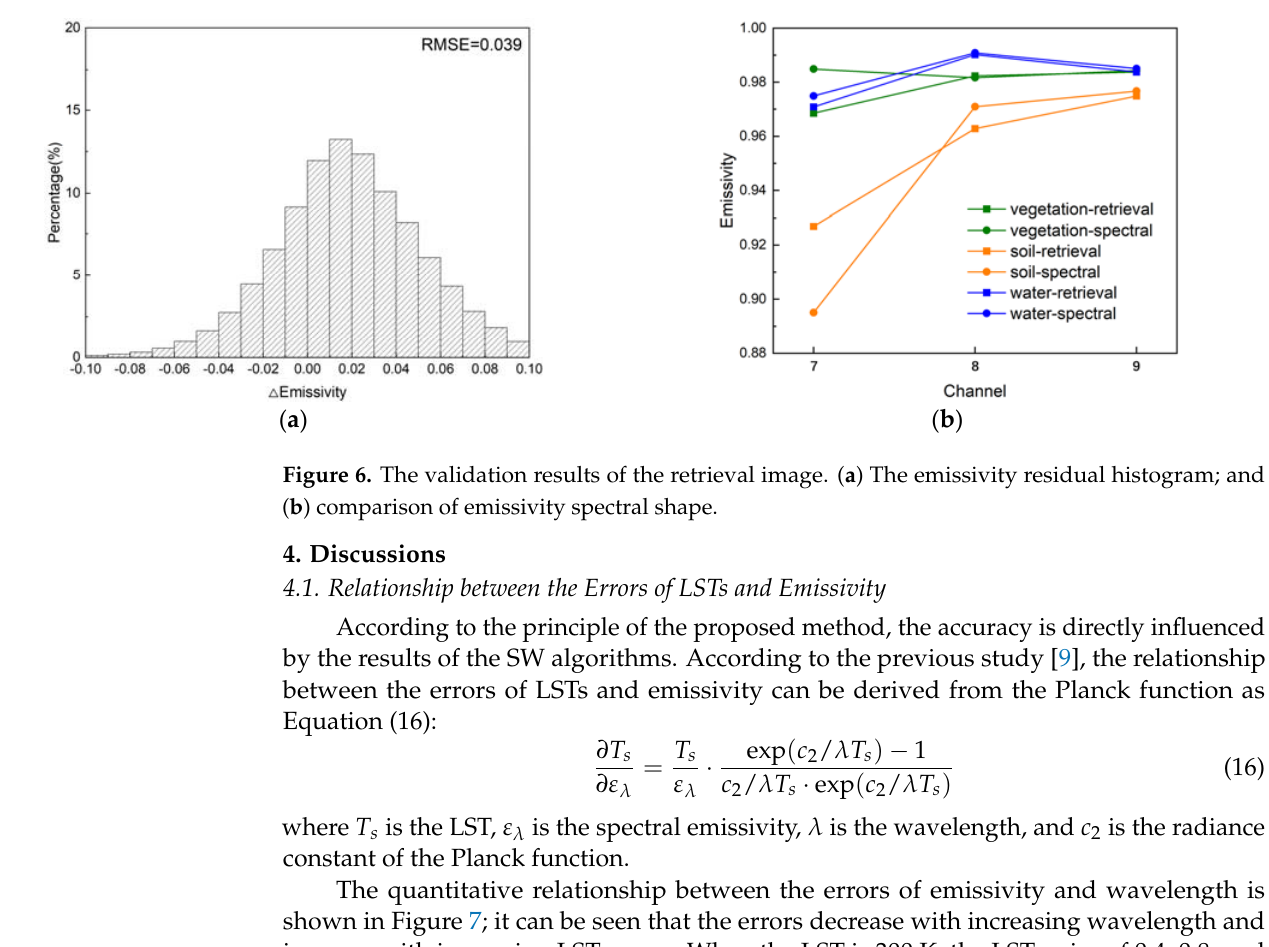
Figure 5. Application results of the study area. ( a ) The MIR emissivity retrieval image; and ( b ) the land cover map.